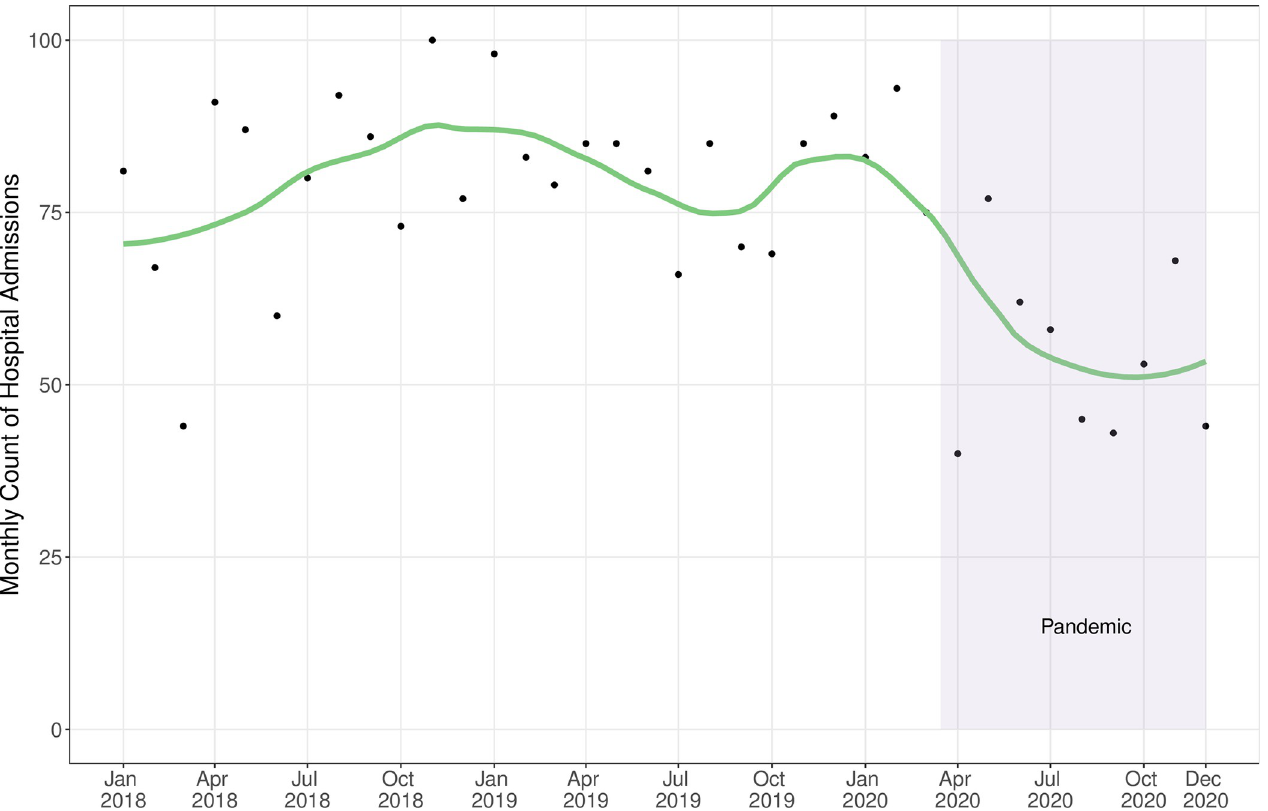
Fig 1. Monthly count of long-term care resident admissions to general internal medicine wards (2018–2020), Toronto, Ontario, pandemic period highlighted.